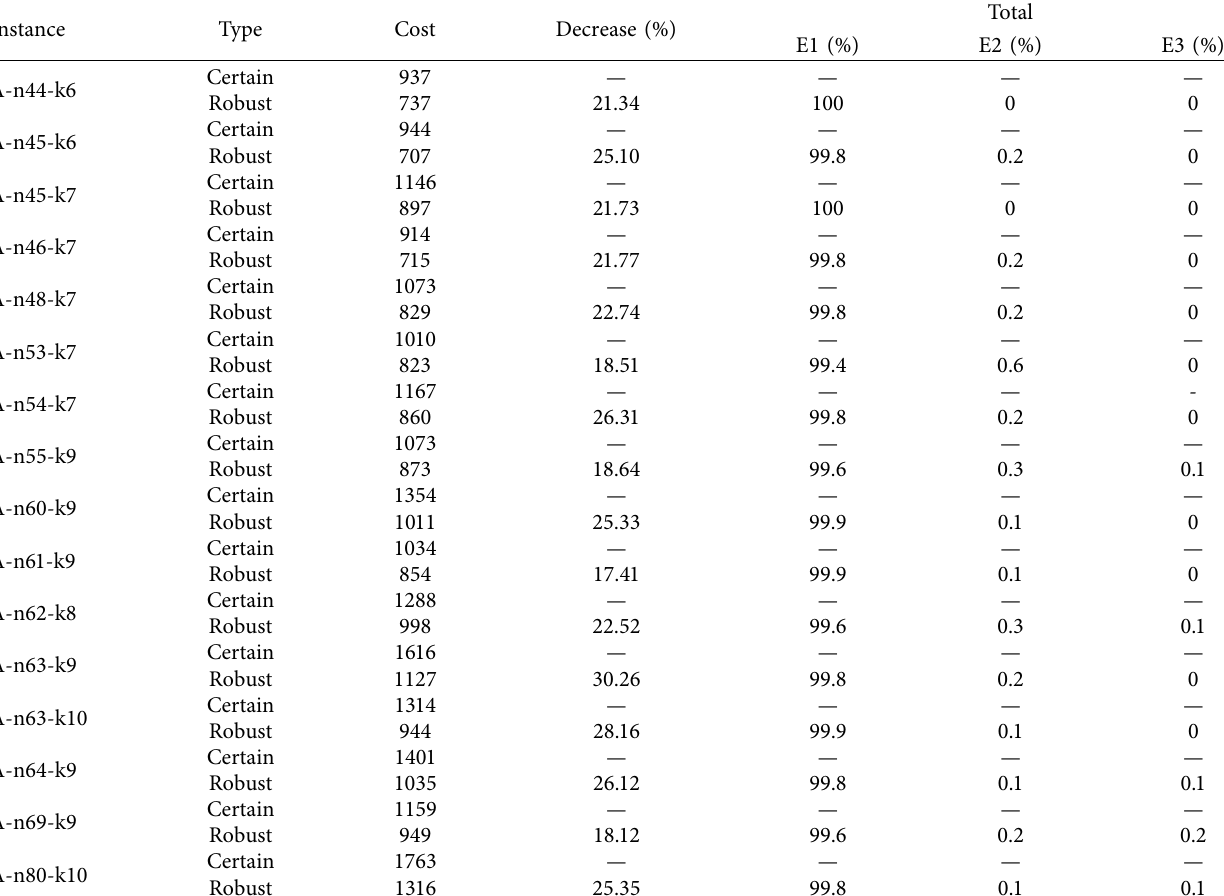
Table 3: VRPUC set A standard instance test